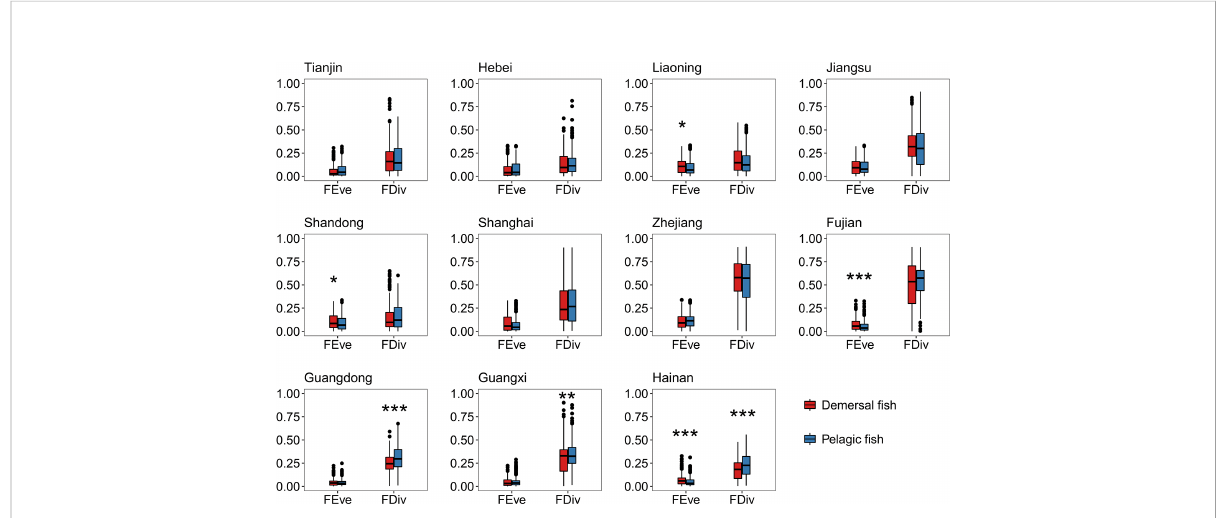
FIGURE 4 Comparison of relative contributions of fi shes with different water column positions to functional diversity for 11 provinces. The results of Wilcoxon rank-sum tests are shown upon each plotted item (* p < 0.05; ** p < 0.01; *** p < 0.001; Supporting Information Table S5 shows the complete Wilcoxon rank-sum tests. FEve, functional evenness; FDiv, functional